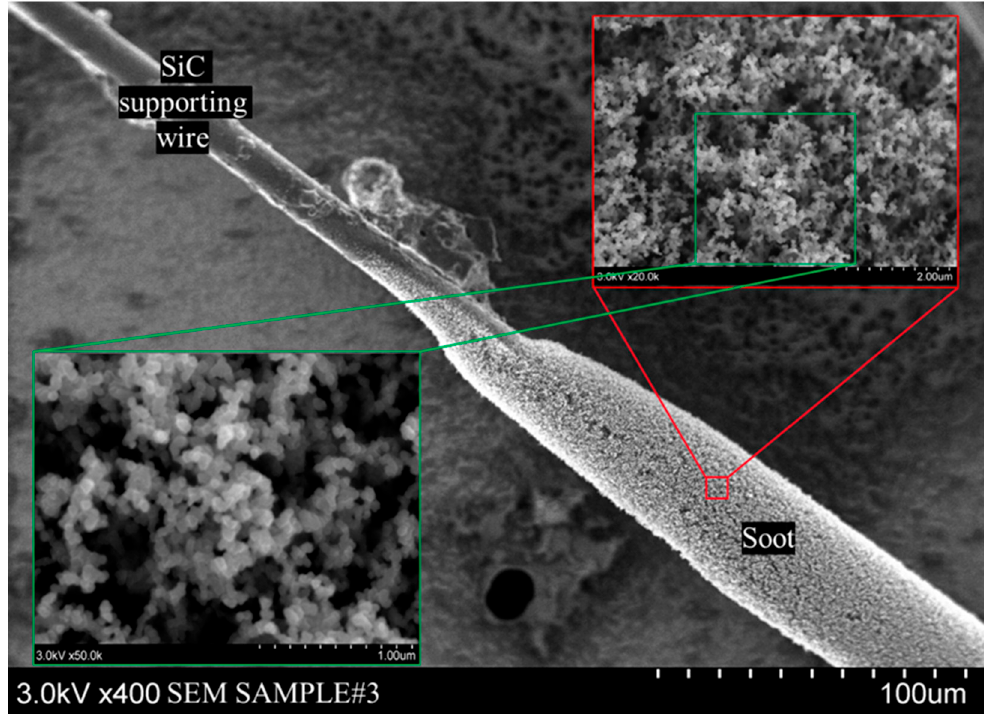
Figure 15. Soot sample from Colorado crude oil combustion experiment shown at various stages of magnification.